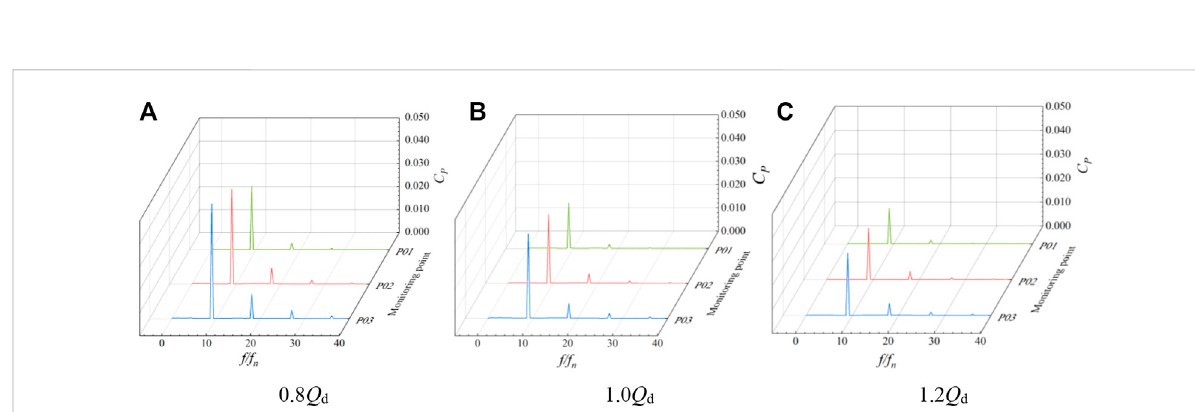
FIGURE 16 Pressure pulsation spectrum of impeller inlet monitoring points 1 – 3 at different fl ow rate conditions.